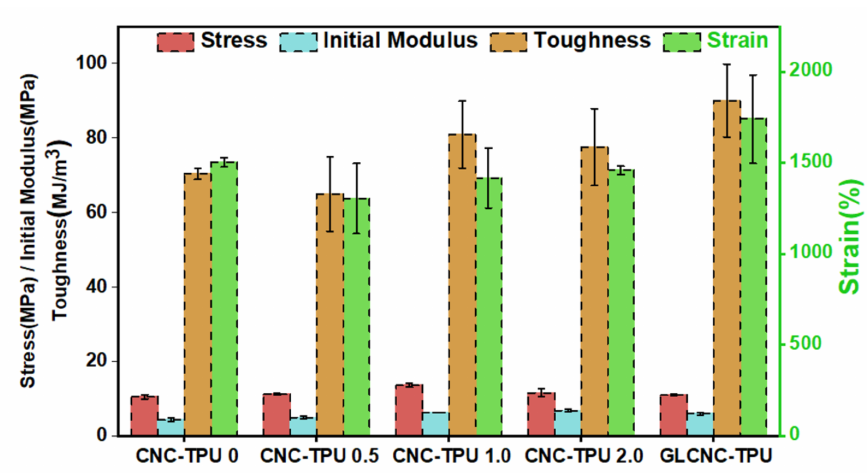
Figure 5. Stress, strain, initial modulus, and toughness of CNC/TPU and GLCNC-TPU composite films.